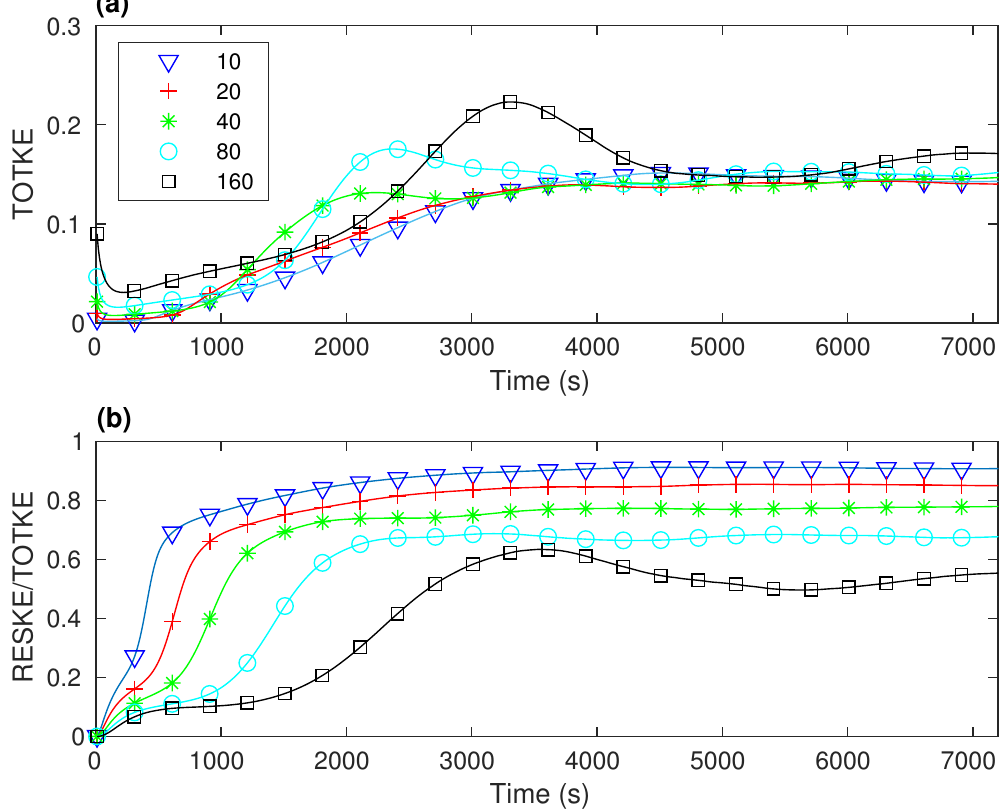
Figure 2. Time series of ( a ) total (resolved plus sub-filter) kinetic energy (TOTKE) in m 2 s − 2 and ( b ) the ratio of resolved kinetic energy (RESKE) to total kinetic energy, for CBL1 simulations. Each line is for a simulation with a different grid length, the values in m being indicated in the inset. Table 1. A summary of the specifications for the convective boundary layer simulations